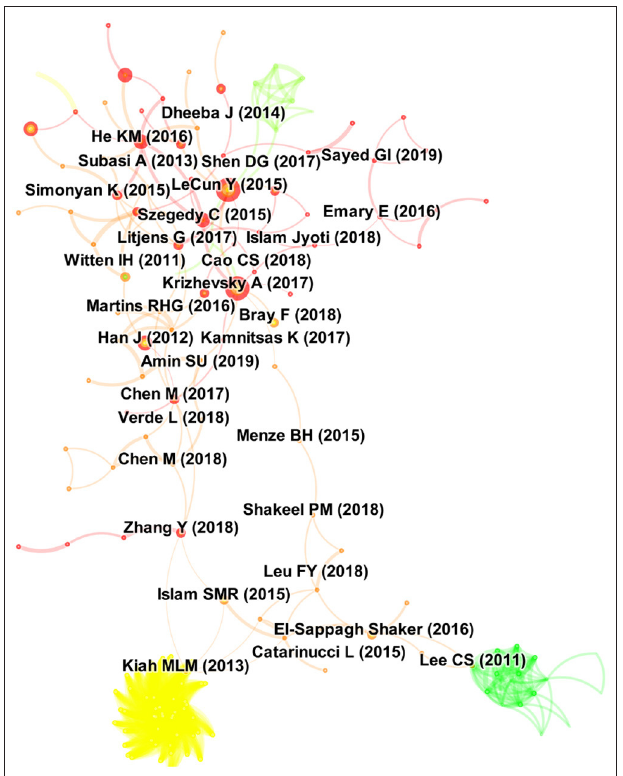
FIGURE 4 | Central universities in the area of digital health in the Arab world. FIGURE 5 | Central publications in the area of digital health in the Arab